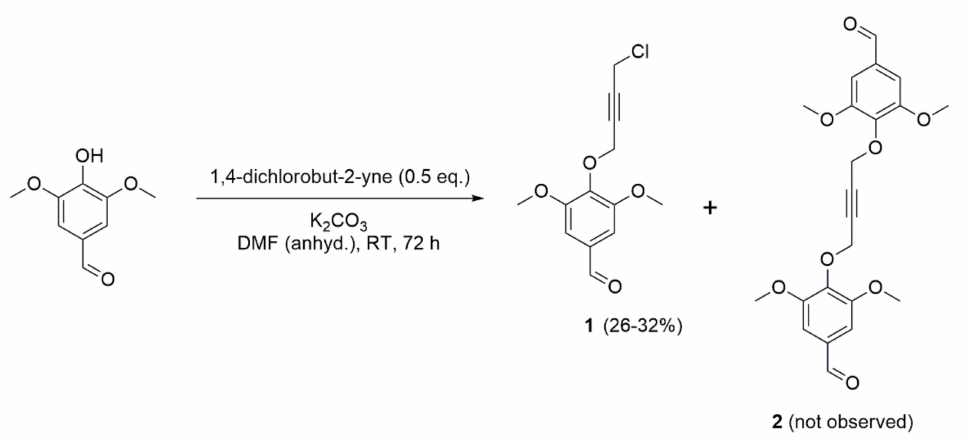
Figure 4. Synthetic scheme for the preparation of 1-(4-formyl-2,6-dimethoxyphenoxy)-4-chlorobut-2-